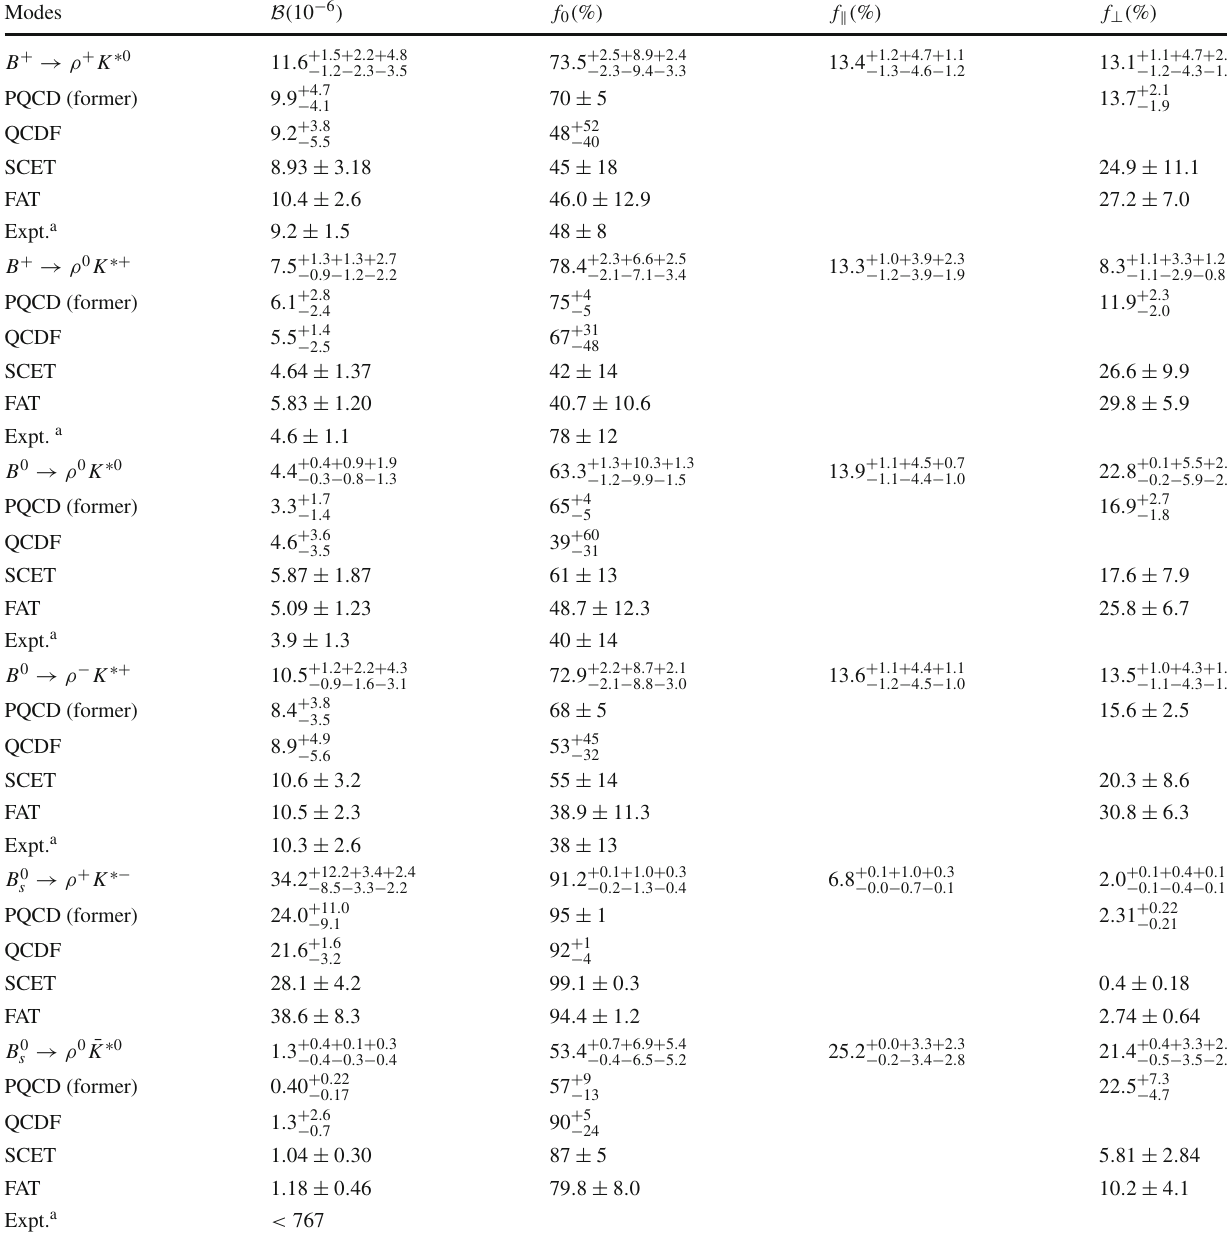
Table 4 CP -averaged branching ratios and polarization fractions of the two-body B ( s ) → ρ K ∗ decays in the PQCD approach compared with the previous predictions in the PQCD approach [18], the updated predictions in the QCDF [3,4], SCET [25] and FAT [26]. Experimental results for branching ratios are taken from Table 1 and for polarization